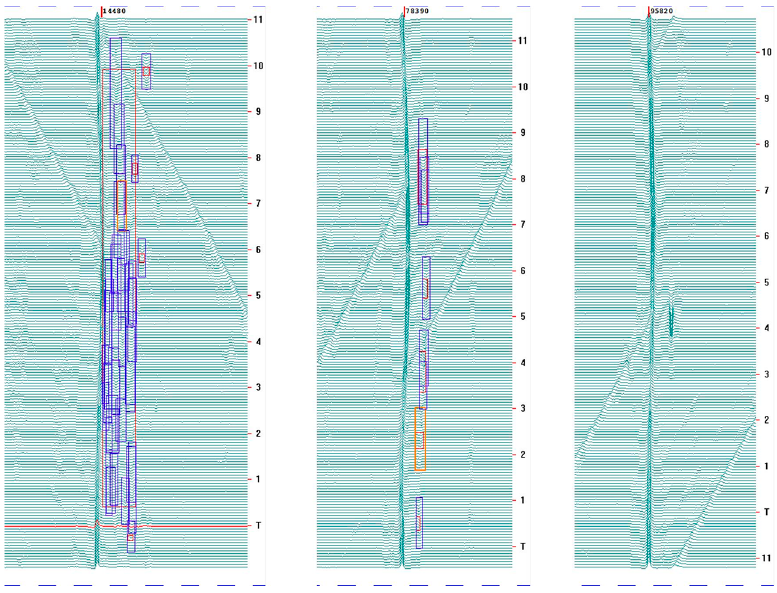
Figure 3. Type 1 magnetic flux leakage (MFL) signals.